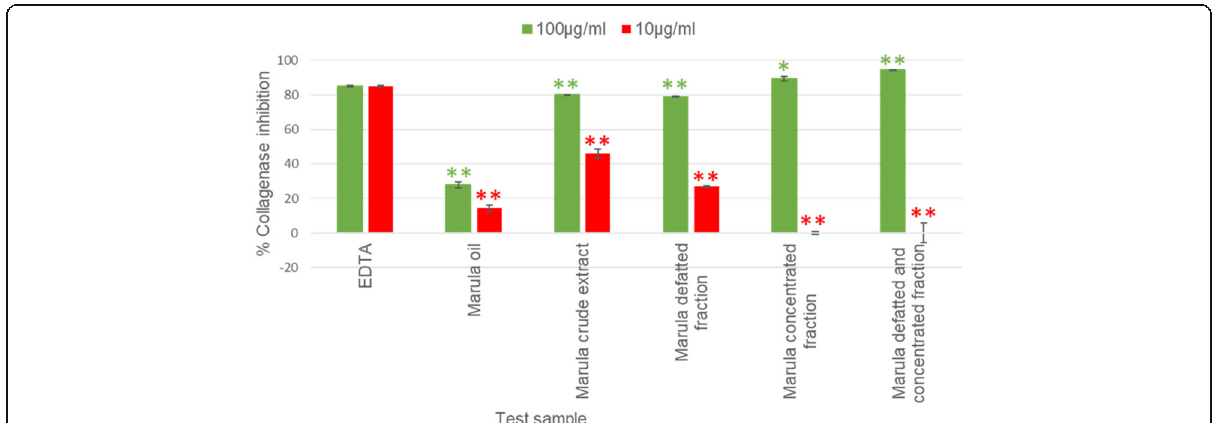
Fig. 2 Collagenase inhibition of the fractions with improved quality and Marula oil tested at 100 and 10 μ g/ml (Error bars represent SEM, with n =3). = P <0.05, = P <0.01 represent a significant difference with EDTA at 10 μ g/ml and = P <0.05, = P <0.01 represent a significant difference with EDTA at 100 μ g/ml